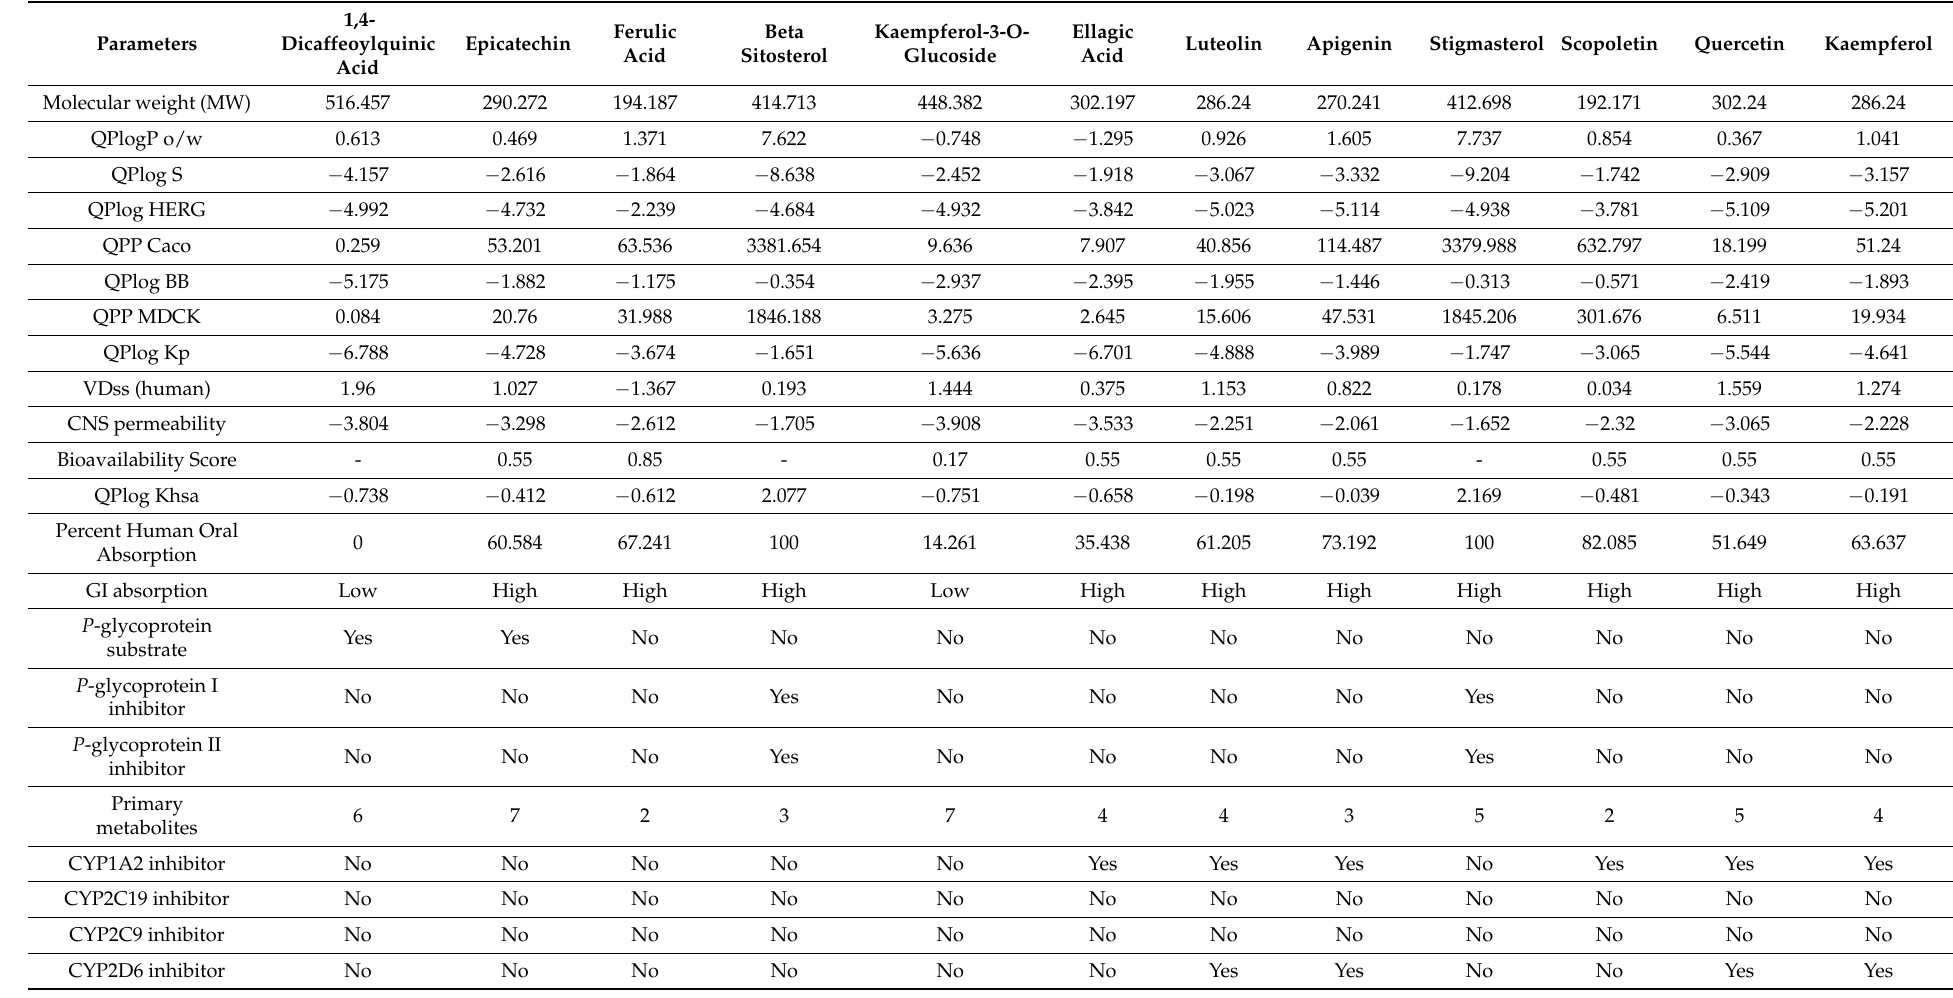
Table 3. ADMET and drug-likeness profiling of bioactive